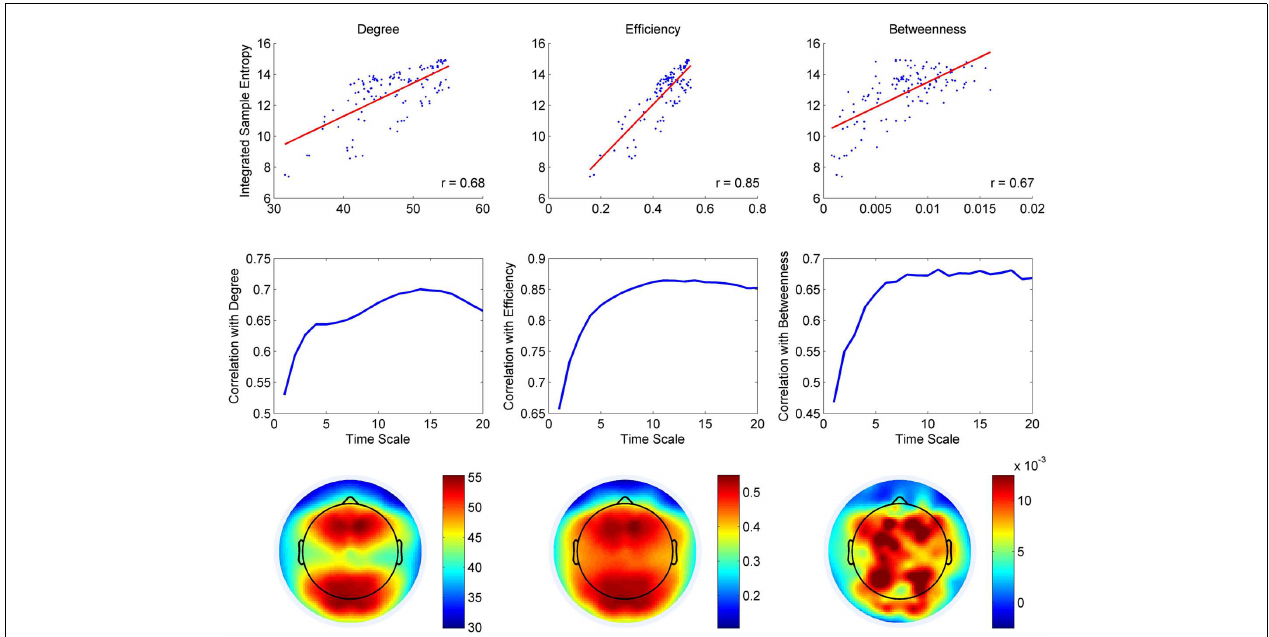
FIGURE 2 | Multiscale entropy and functional embedding. Top row: scatter plots and regression lines depict the relationship between S E and centrality across all electrodes (both have been integrated across temporal scales). Middle row: the correlation coefficient between S E and each of the three